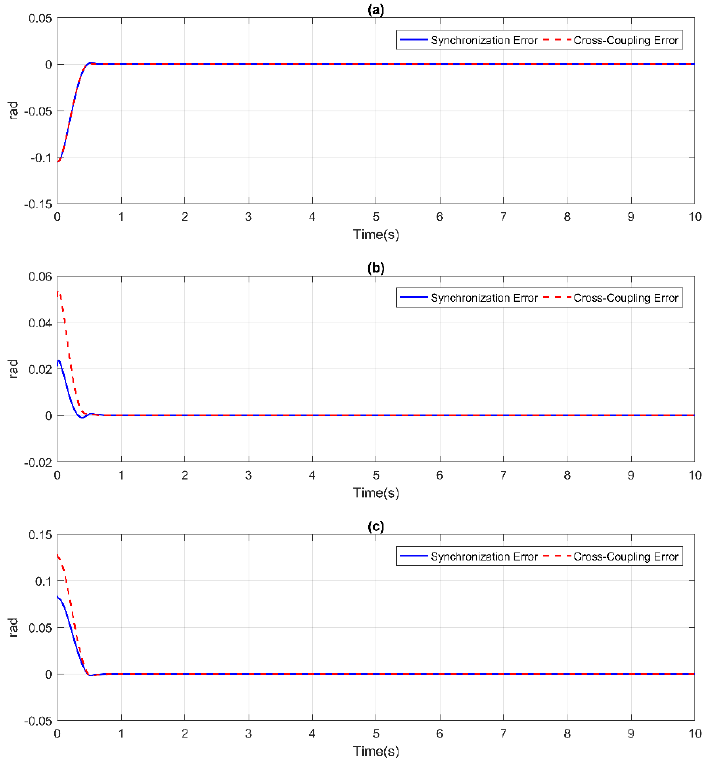
Figure 7. The Synchronization Error and Cross-Coupling Error in the active joint space ( a ) at Joint 1, ( b ) at Joint 2, and ( c ) at Joint 3.